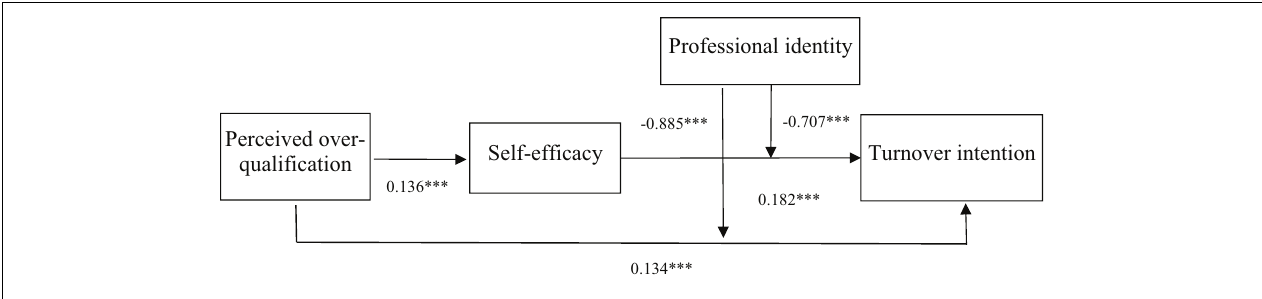
FIGURE 3 | Verified theoretical model. *, **, and *** indicate a significant correlation at the 0.1, 0.05, and 0.01 levels, respectively.